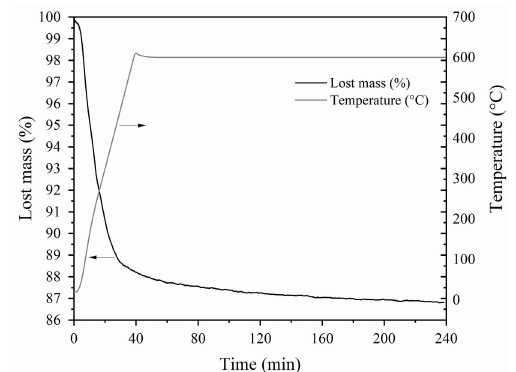
Figure 2. Thermogravimetric analysis of the HAS3 sample.